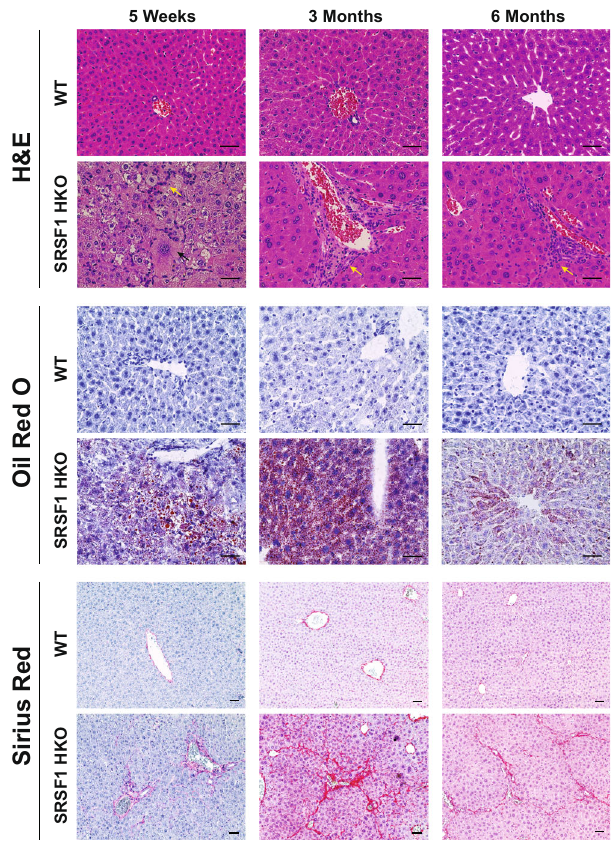
Fig. 3 | Acute and reversible NASH-like pathology in adult SRSF1 HKO mice. Representative images of H&E, Oil Red O (red, neutral lipids), and Sirius Red (red, collagen) histological staining of liver tissue harvested from wildtype (WT) and SRSF1 HKO mice at the indicated ages ( n =6 biologically independent animals per group). Yellow and black arrows in H&E staining indicate in fl ammatory in fi ltration andballooningdegeneration,respectively.Scalebar=100microns.Sourcedataare provided as a Source Data fi